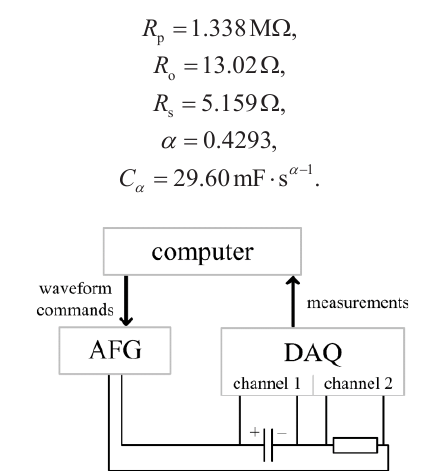
Fig. 2. The applied measurement setup (DAQ – data acquisition device, AFG – arbitrary function generator) .